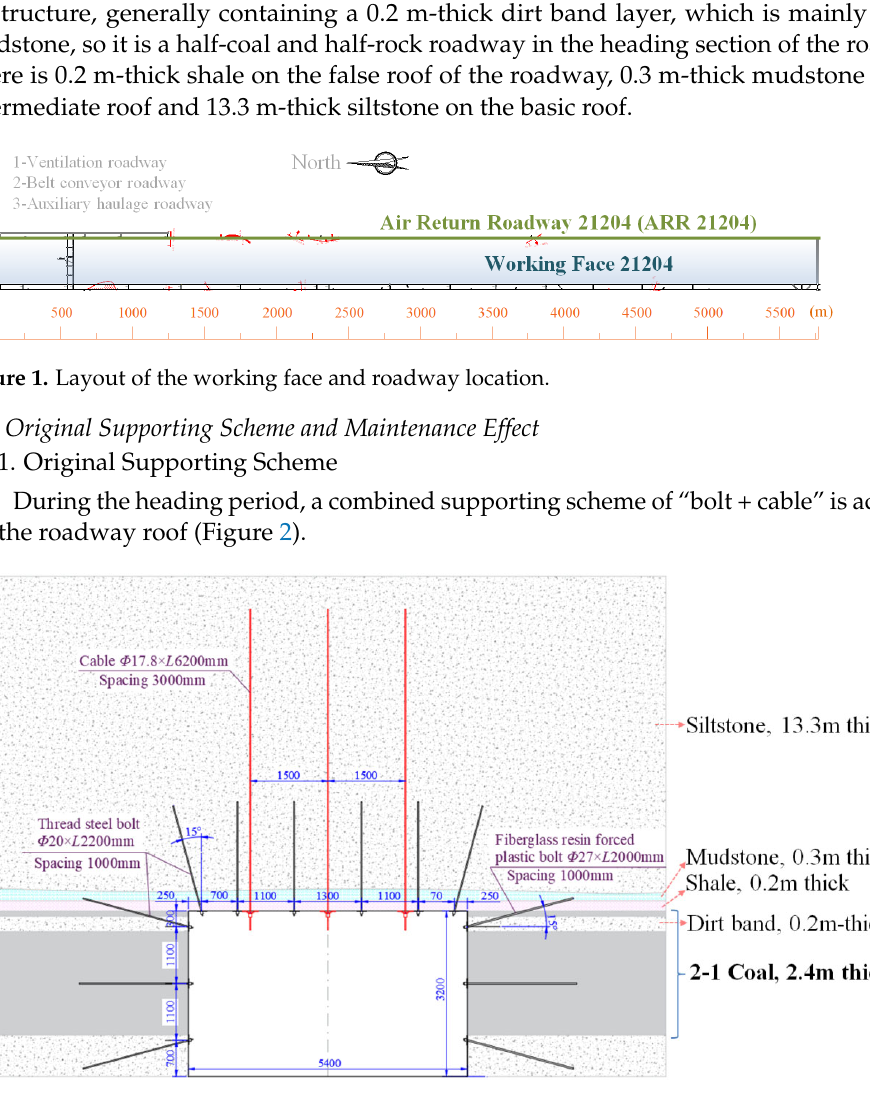
Figure 3. Distribution of roof separation fractures in ARR 21204. 2.3. Problems High ‐ density bolts with a length of 2.2 m are used as the fundamental support on the roof, and low ‐ density cables with a length of 6.2 m are used to strengthen the sup ‐ port. Due to the high density of the bolts, the foundation supporting composed of the 2.2 m ‐ long bolts on the roof is crucial to the stability control of roof. As shown above, the